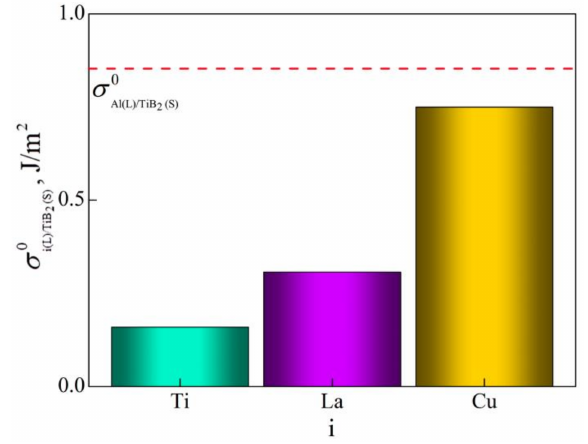
Figure 6. Interfacial energy σ 0